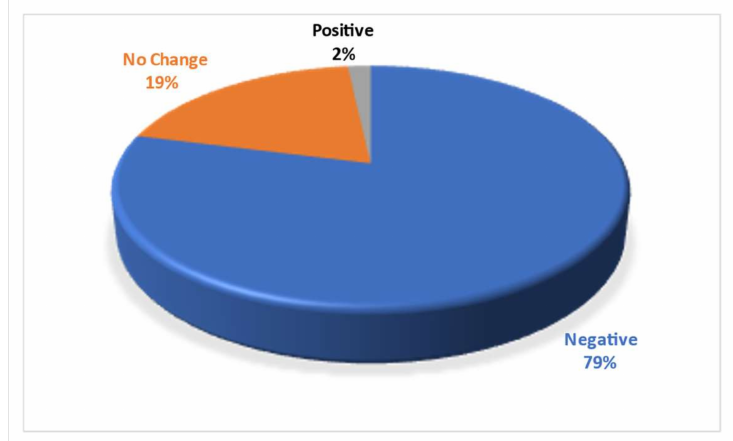
Figure 7. Experimental papers describing negative (79%), positive (2%) or no-change (19%) effects in response to elevated CO 2 concentration on